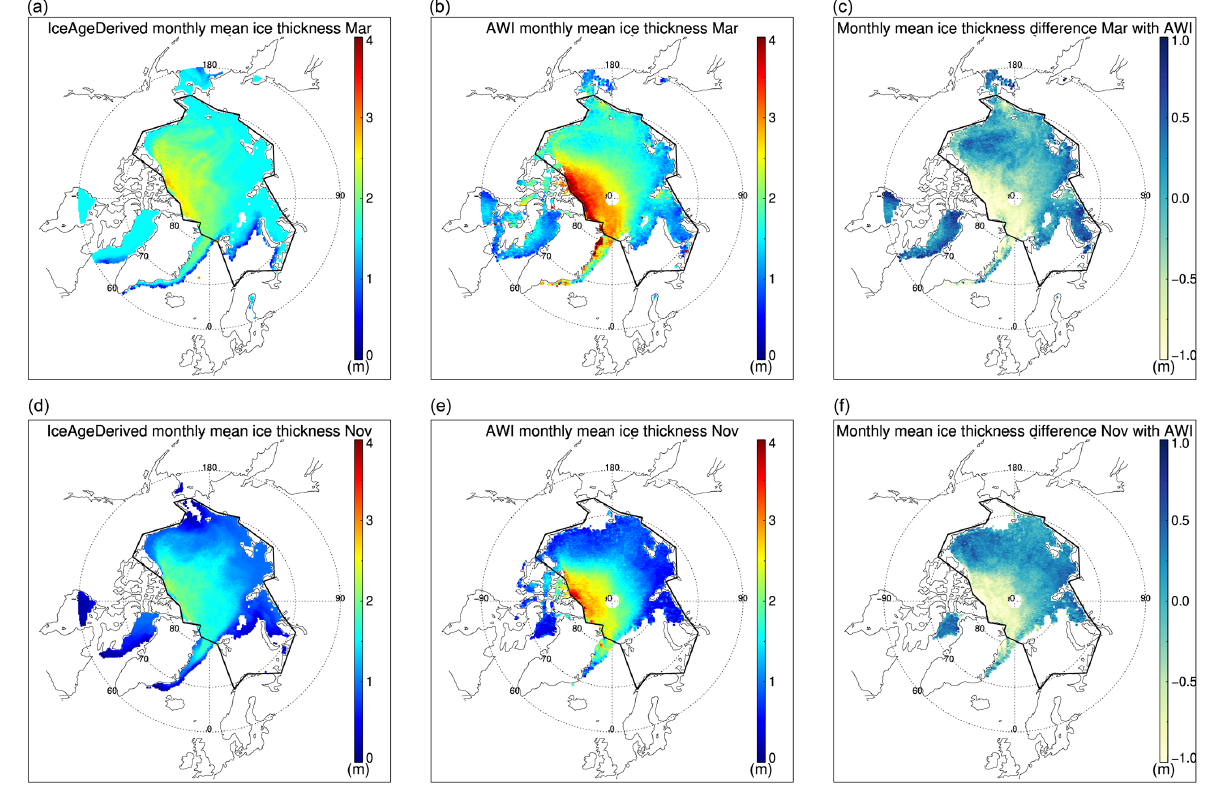
Figure 9. Monthly mean ice thickness from the IceAgeDerived product (a) and AWI CryoSat-2 (b) and their difference in March 2011–2018. Monthly mean ice thickness from the IceAgeDerived product (d) and AWI CryoSat-2 (e) and their difference in November 2011–2018.